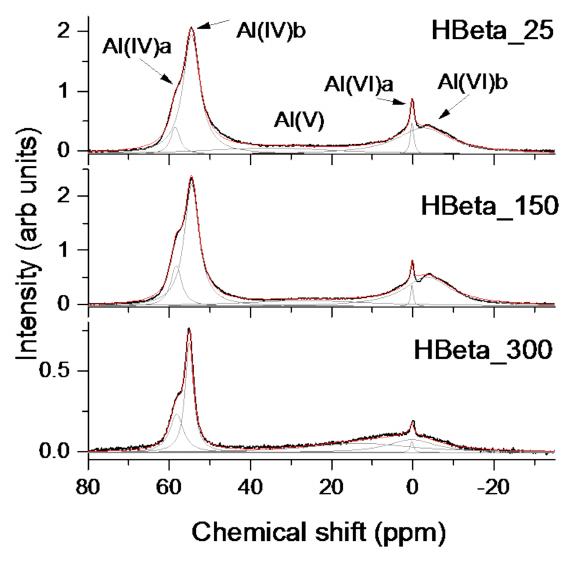
Figure 4. 27 Al-MAS NMR results from H-beta-25, H-beta-150, H-Beta-300 materials. Gray lines show